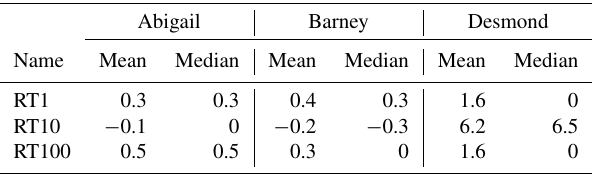
Table 4. Mean and median delays (h) to simulated peaks of each of the named storms for the intervention cases compared to the corre- sponding unmodified